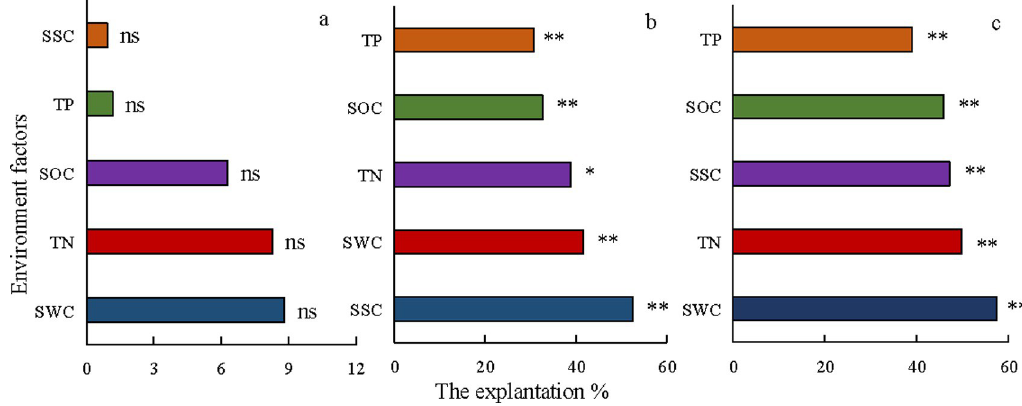
Fig 6. The relative contribution of environmental factors to the desert plant community assembly. Note: ns represents nonsignificant; � and � � represent significant and extremely significant effects of environmental factors on species composition at confidence levels of 0.05 and 0.01,